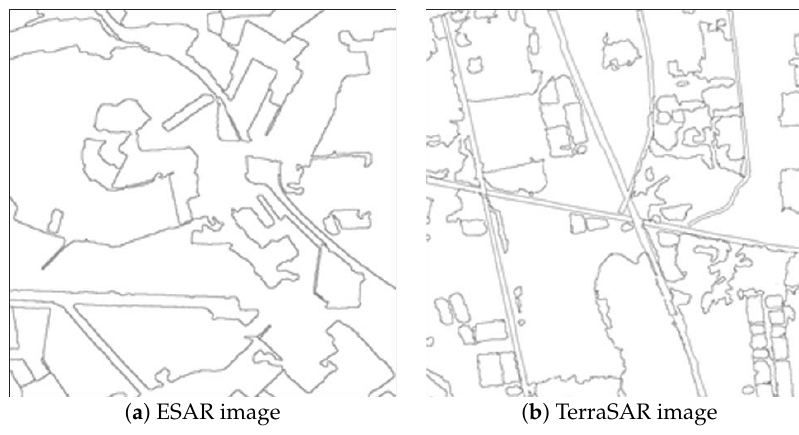
Figure 8. Contour lines for boundary prior knowledge. Table 2. Conditional probability